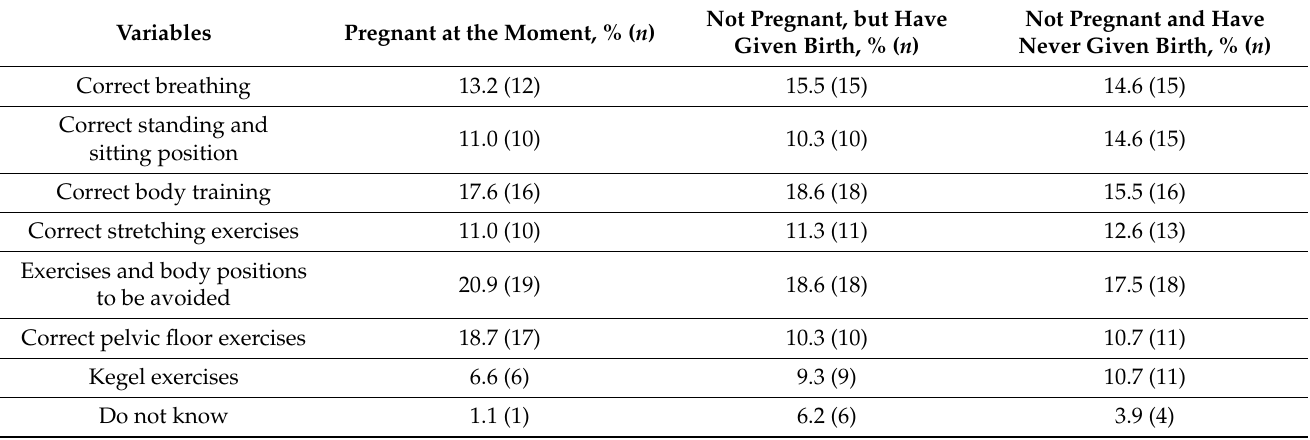
Table 5. Distribution of answers to the question “What information about exercise and its effect during pregnancy you would like to